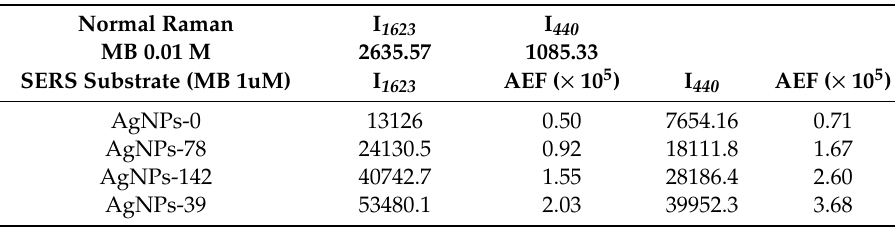
Table 3. Raman and SERS intensity of MB 1 µ M and the calculated AEF at 440 and 1623 cm − 1